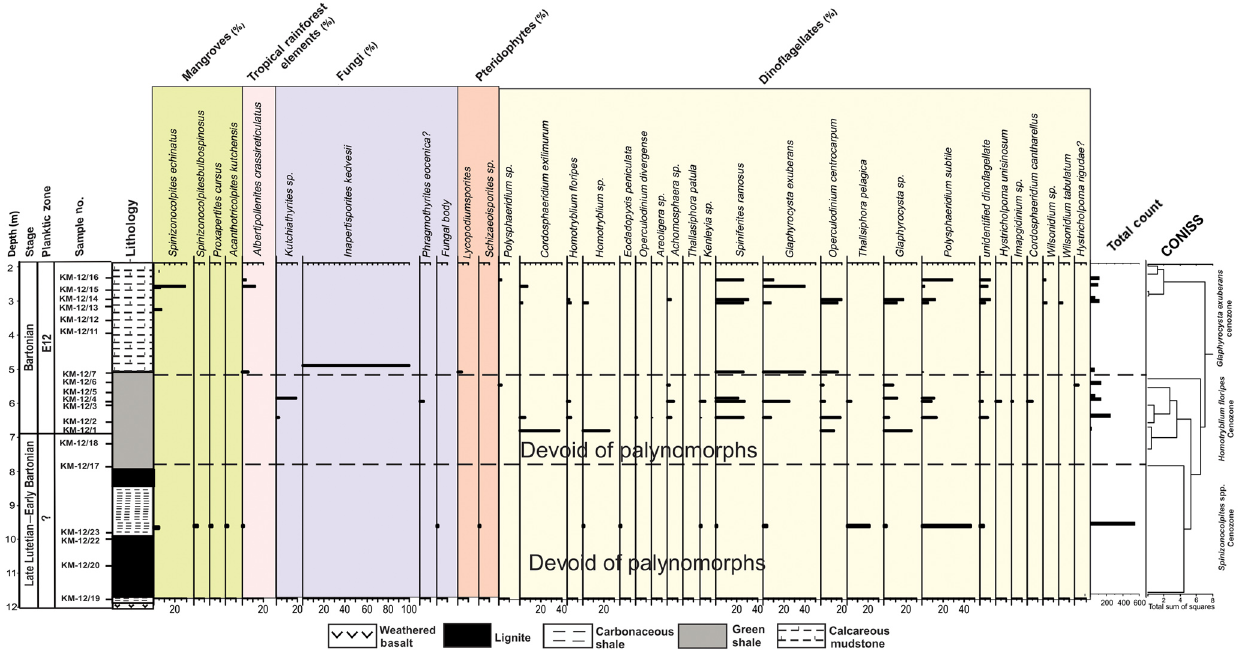
Figure 5. Percentage distribution of palynomorphs in the Matanomadh lignite mine section, Kutch Basin.